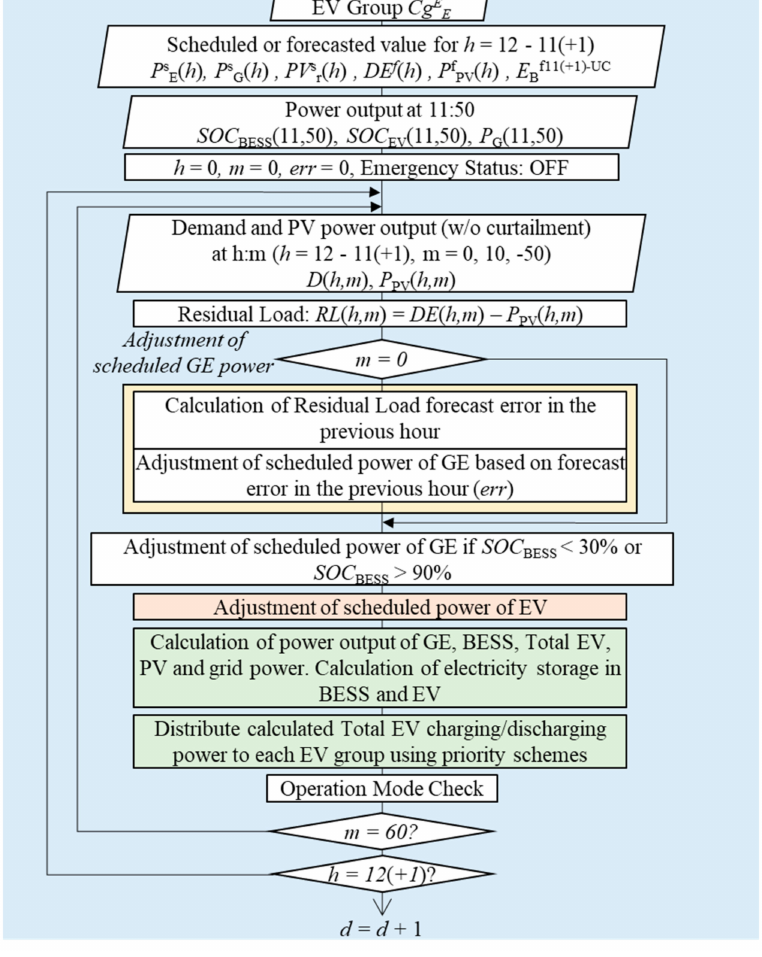
Figure 11. Calculation flow of the TED